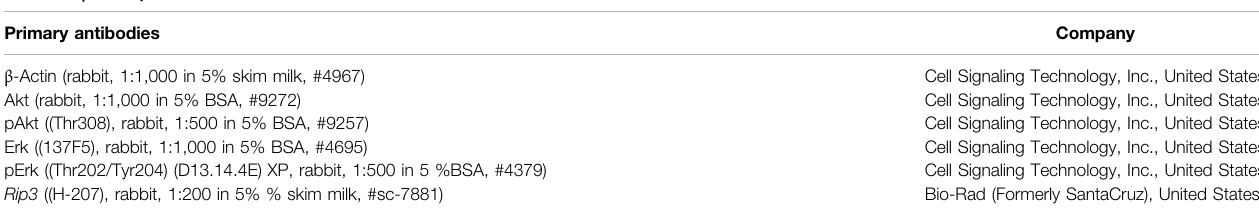
TABLE 2 | Primary antibodies. Primary antibodies